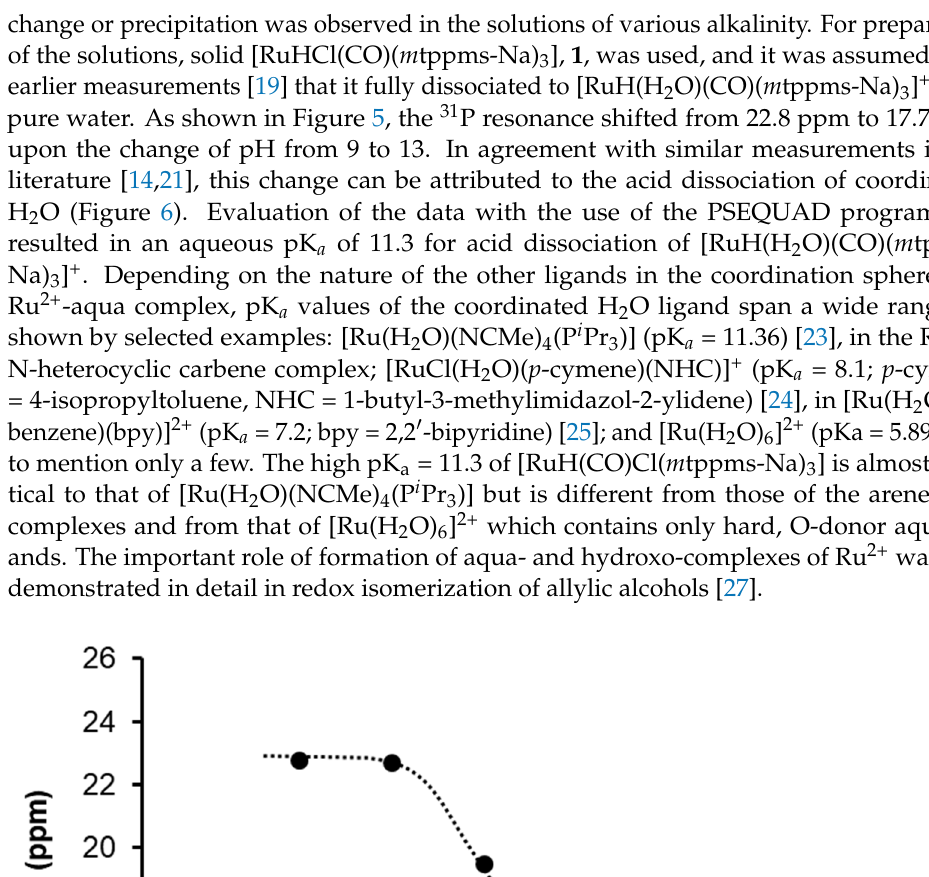
Figure 6. Acid dissociation of coordinated H 2 O in [RuH(H 2 O)(CO)( m tppms ‐ Na) 3 ] + .